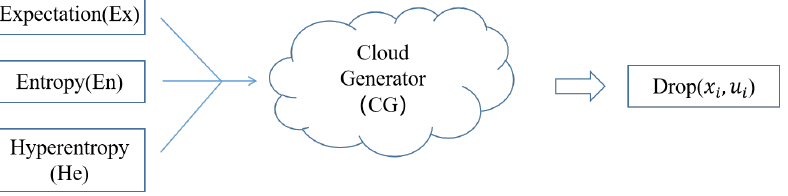
Figure 3. Forward cloud